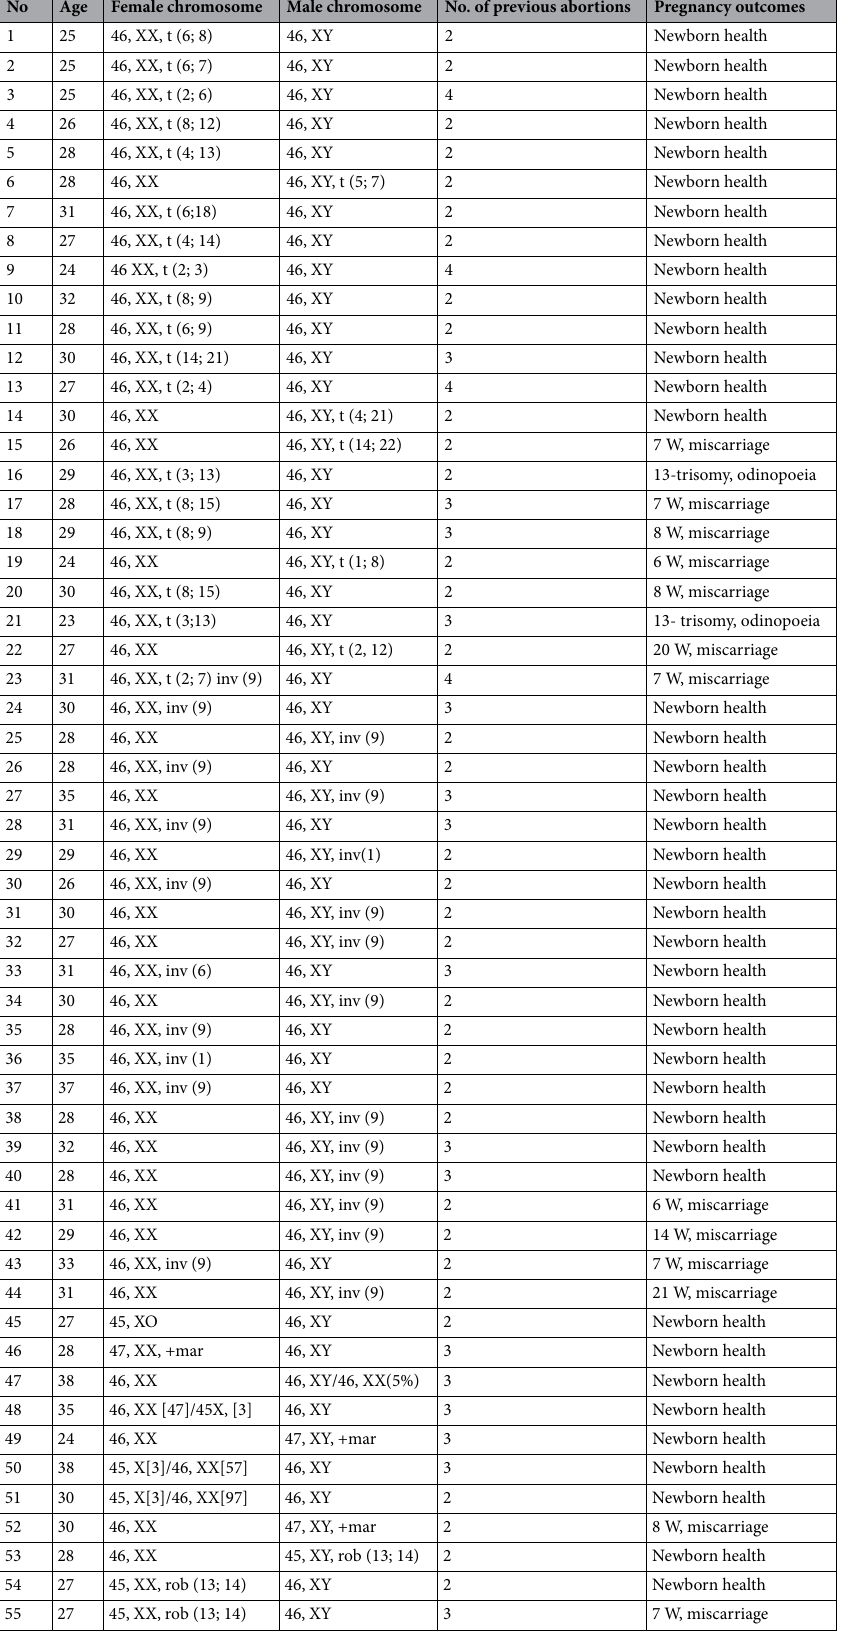
Table 2. Detailed chromosome karyotype of 55 RM carriers and their pregnancy